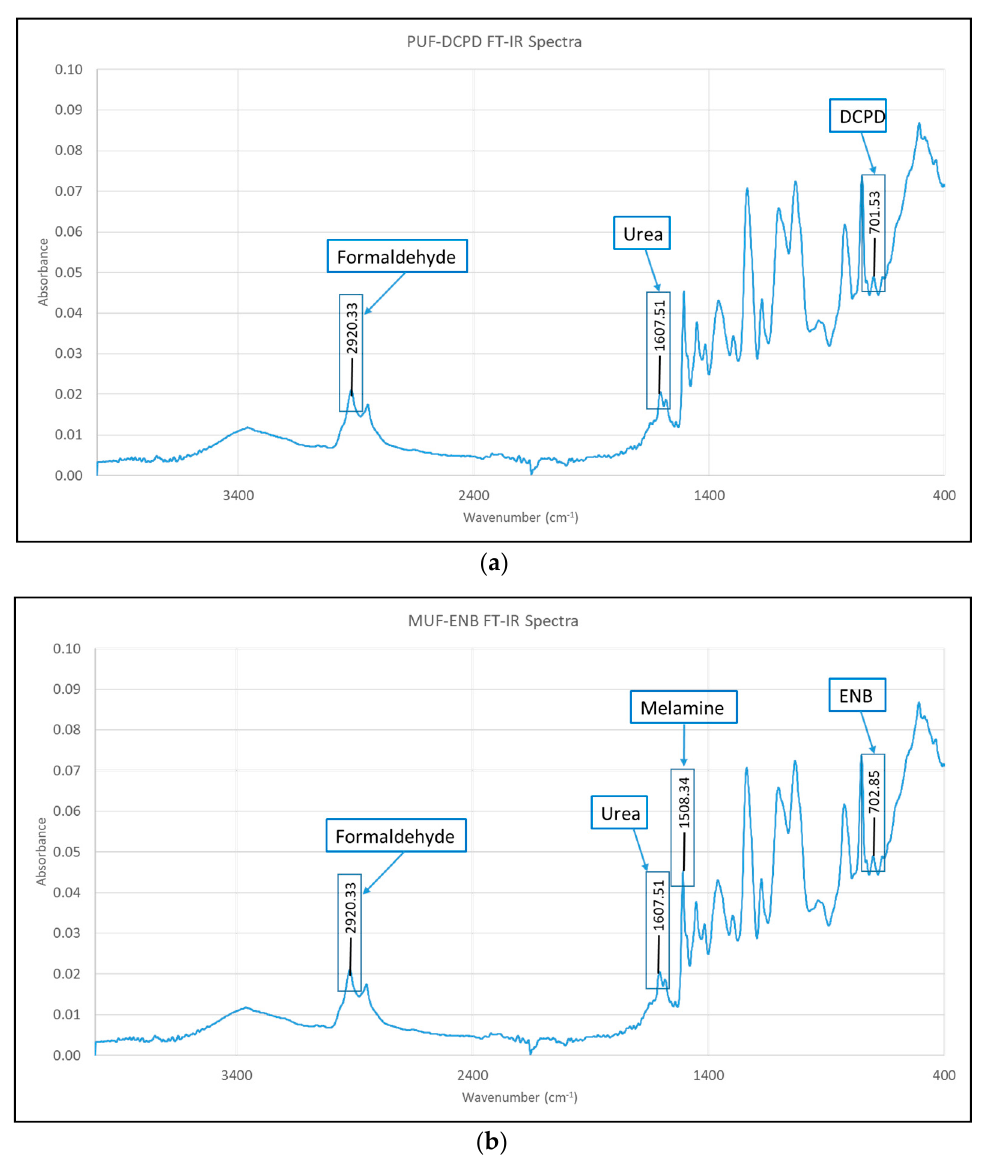
Figure 11. FT-IR spectra of the main ( a ) PUF-DCPD and ( b ) MUF-ENB microcapsule